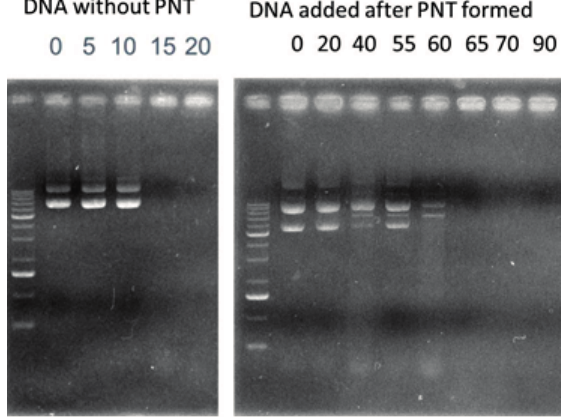
Figure 5. Stability of CAP3 pRFP-C-RS (7.4 kb) with cyclo -( D -Trp-Tyr) peptide nanotubes (PNTs) analyzed by DNase I. Samples treated with DNase I and CAP3 pRFP-C-RS added after PNTs formed at each time point were electrophoresed on 0.8% agarose gel. The markers (M) represented DNA of 10, 8, 6, 5, 4, 3, 2.5, 2, 1.5, 1, 0.75, 0.5 and 0.25 kb in size. At the 0 min time point of the reaction performed without DNase I, supercoil and multi-mer forms of DNA were